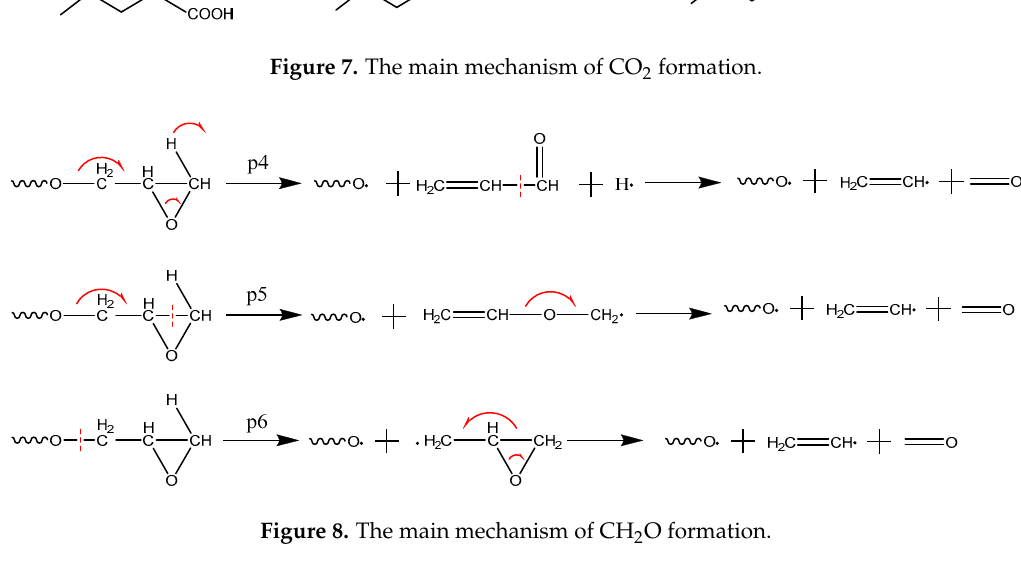
Figure 8. The main mechanism of CH 2 O formation.